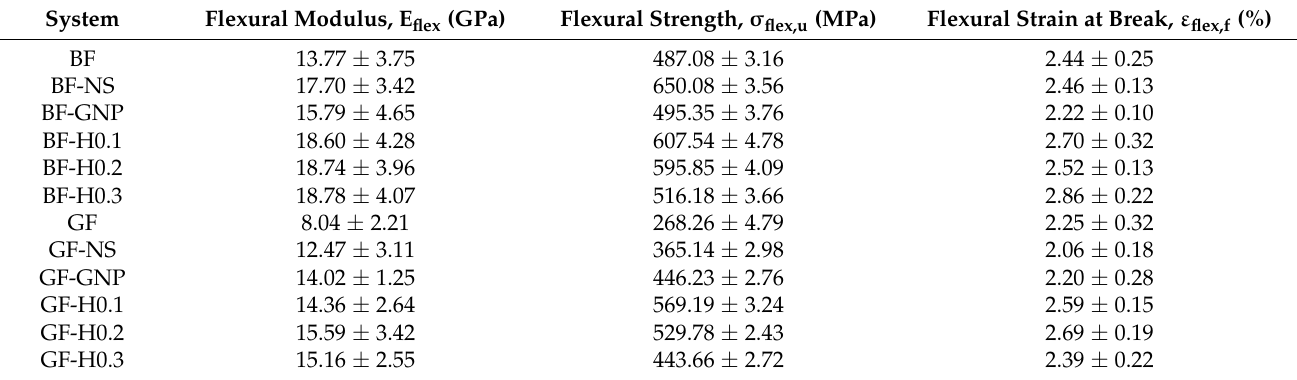
Figure 8. Typical flexural stress-strain response of BFRP and GFRP embedded with hybrid nanofiller. Table 6. Flexural properties of FRP embedded with hybrid nanofiller.